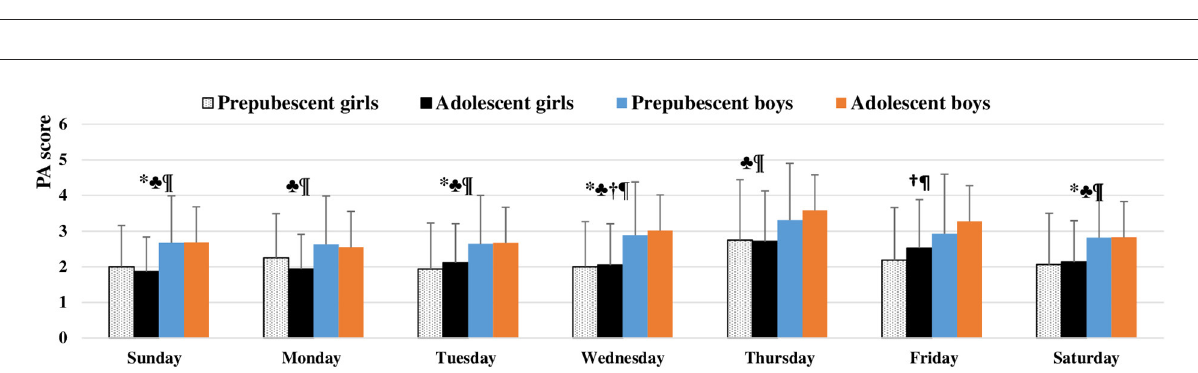
FIGURE2 Self-reported physical level and physical activity during physical education class, lunch, right after school, evening and weekend among Saudi students stratified by gender and age category. *significant difference in prepubescent boys vs. prepubescent girls; ♣ significant difference in prepubescent boys vs. adolescent girls; † significant difference in adolescent boys vs. prepubescent girls; ¶ significant difference in adolescent boys vs. adolescent girls. Physical activity questionnaire for older children PAQ-C (Kowalski et al., 2004), scored on a 5-point scale; 1 corresponds to lowest PA, and 5 corresponds to highest PA. The values of PA are presented as means ( ± SD).